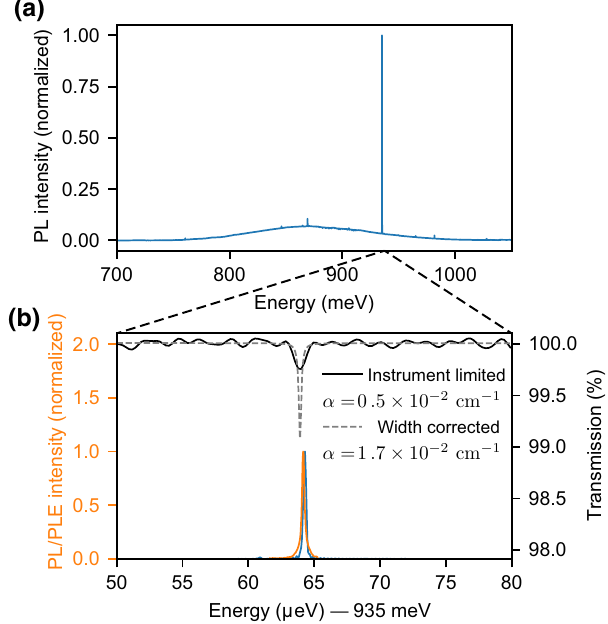
FIG. 2. (a) PL spectrum of a T center ensemble in 28 Si. (b) High-resolution PL spectrum about the TX 0 zero-phonon peak (blue) and PLE spectrum of the same sample (orange). The cor- responding absorption spectrum (black) is instrument resolution limited. We calculate an area-preserving corrected absorption spectrum (dashed black line) with linewidth and shape matched to the PLE